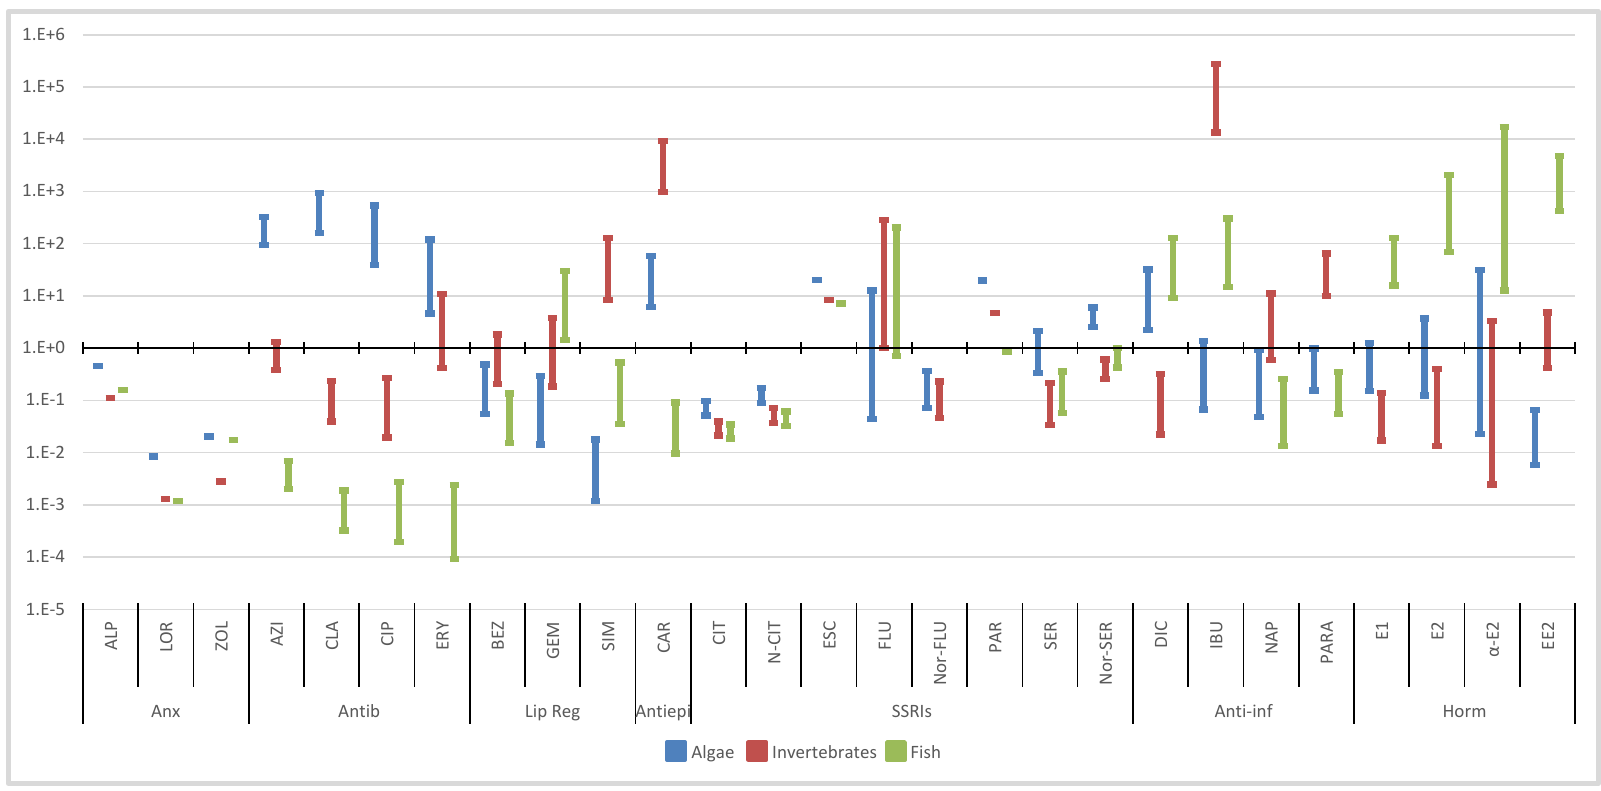
Figure 4. Median and maximum risk quotients of pharmaceuticals in WWIs for the three trophic levels. (Anx—anxiolytics; Antib—antibiotics; Lip reg—lipid regulators; Antiepi—antiepileptics; SSRIs—Selective serotonin reuptake inhibitors; Anti-inf—anti-inflammatories; Horm—hormones).